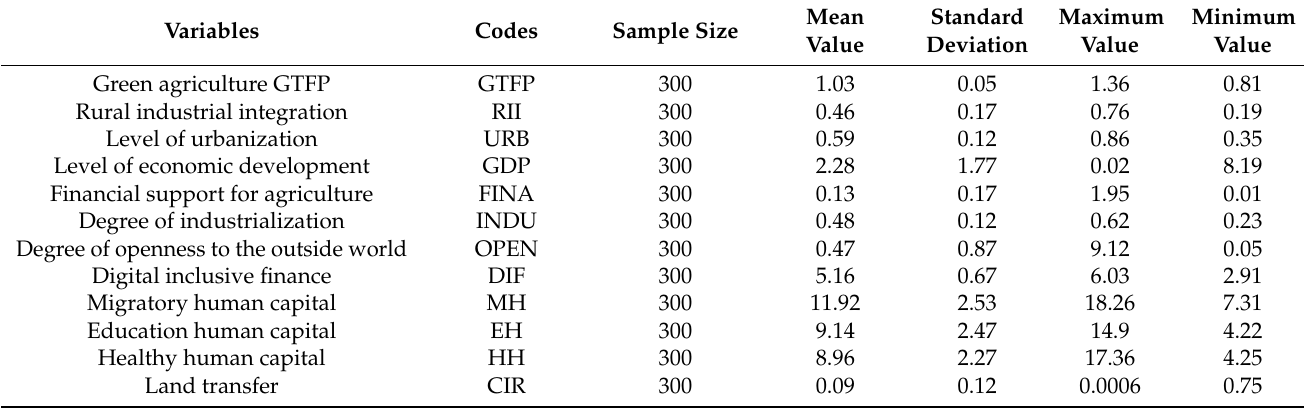
Table 3. Descriptive statistics of